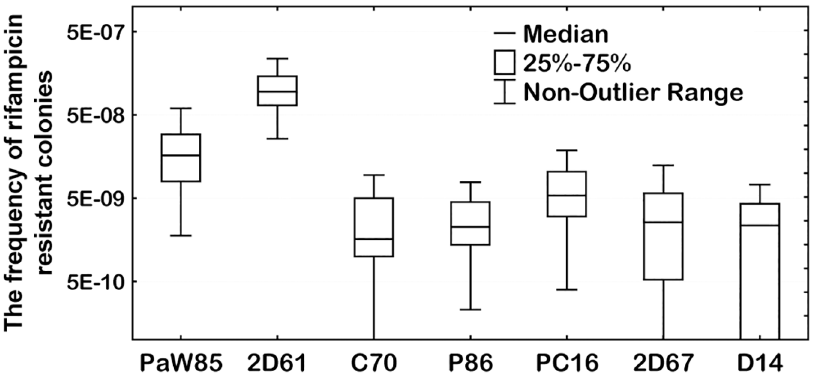
Fig 1. Median values of the spontaneous Rif r mutant frequencies of the indigenous strains and the laboratory referencestrain PaW85. Presentedare only the results for strains exhibitingthe mutant frequency statistically significantly different from that of the reference strain PaW85 (the Kruskal-Wallis test, p < 0.006;S1 Table).Isolate D2RT is missing from the figure becausethe median value of the frequency of Rif r mutants of this strain was 0 (the mean value of Rif r frequency of this strain was 1.07 x 10 − 9 ).